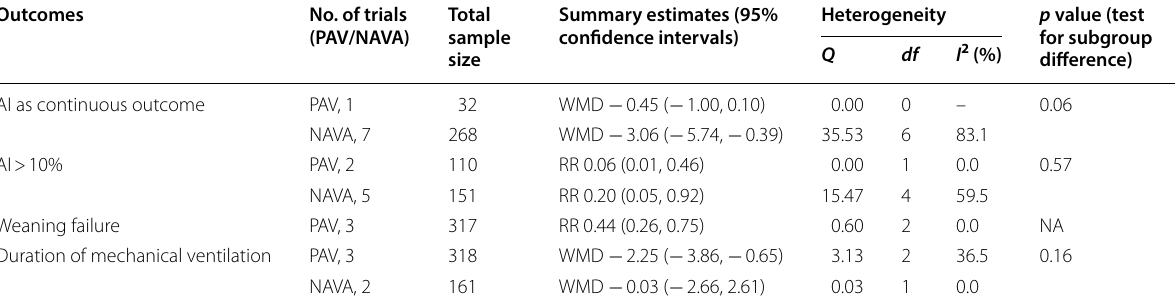
Table 4 Subgroup analyses of primary